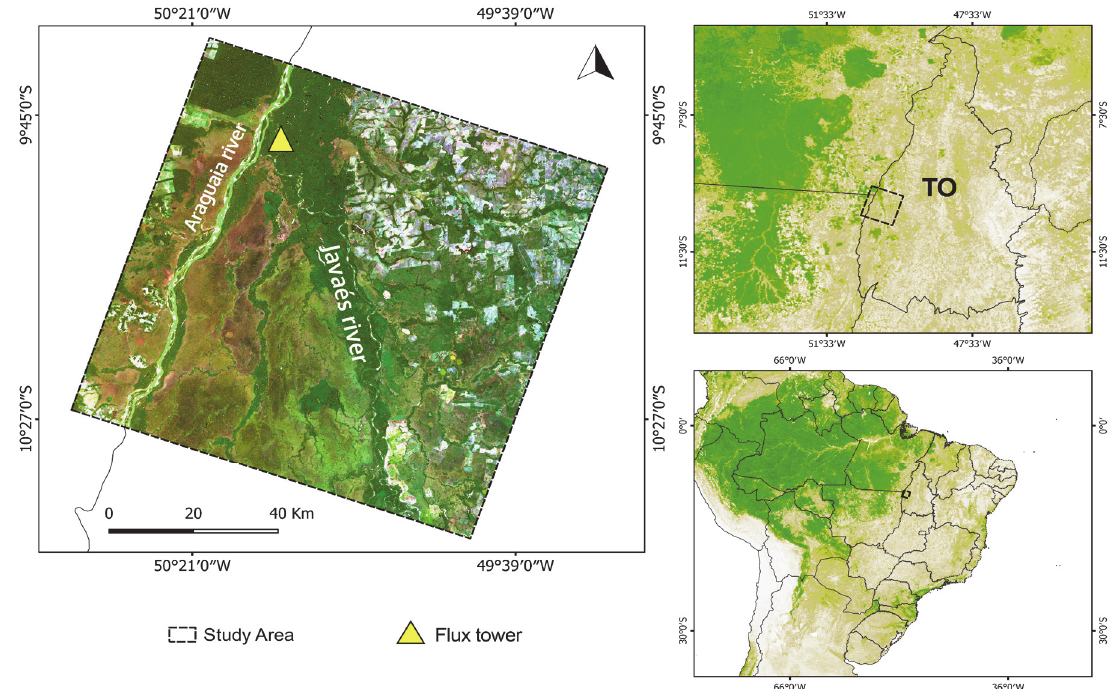
Figure 2. Characterization of the transitional area between tropical forest and savanna vegetation in the Brazilian state of Tocantins (TO) and location of the eddy covariance measurements at the Bananal Javaés (JAV) site (flux tower), using the Landsat 5 image path-row 223–067 from July 2005 ( left ). MODIS tree cover fraction is used to illustrate the large-scale vegetation spatial pattern ( right ). Micrometeorological and eddy covariance measurements at the Bananal Java é s site